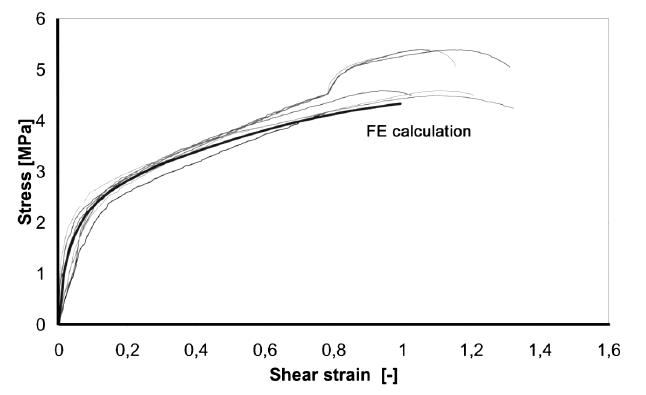
Figure 9: Comparison of FE calculation with experimental results for acrylic adhesive.